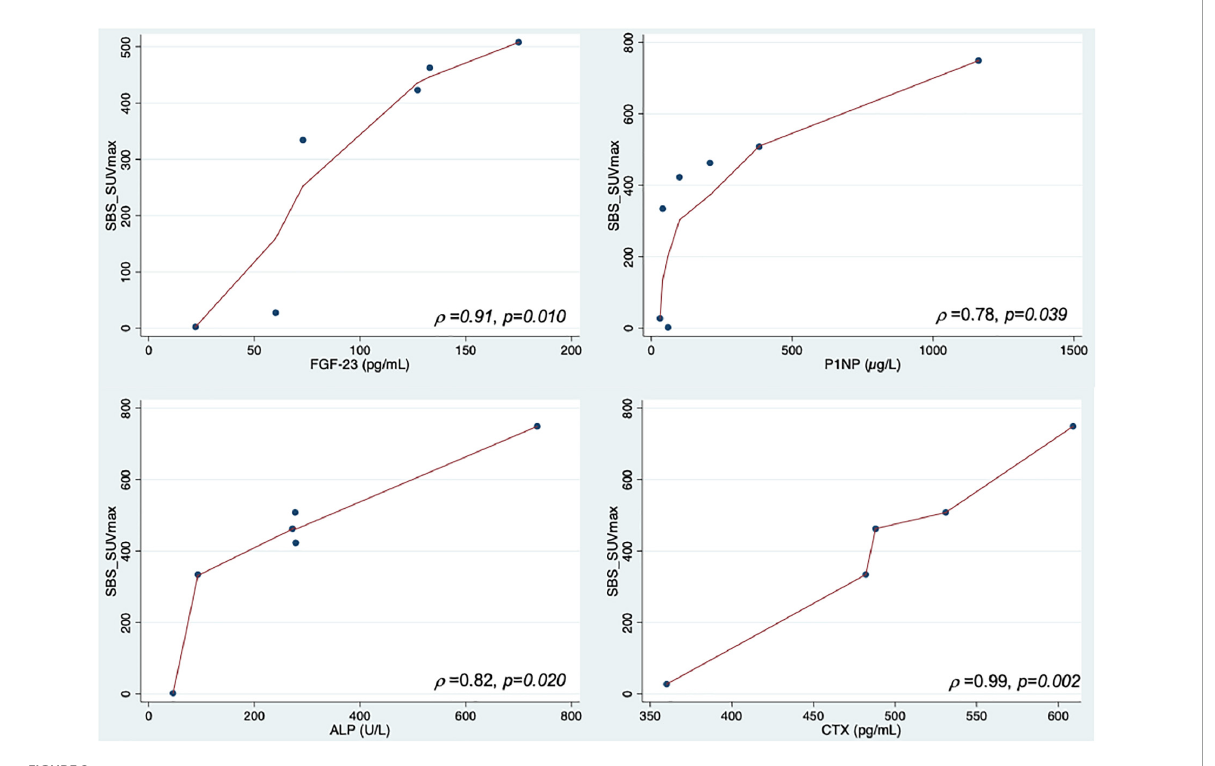
FIGURE2 Correlations between SBS_SUV max and FGF-23, ALP, P1NP and CTX.